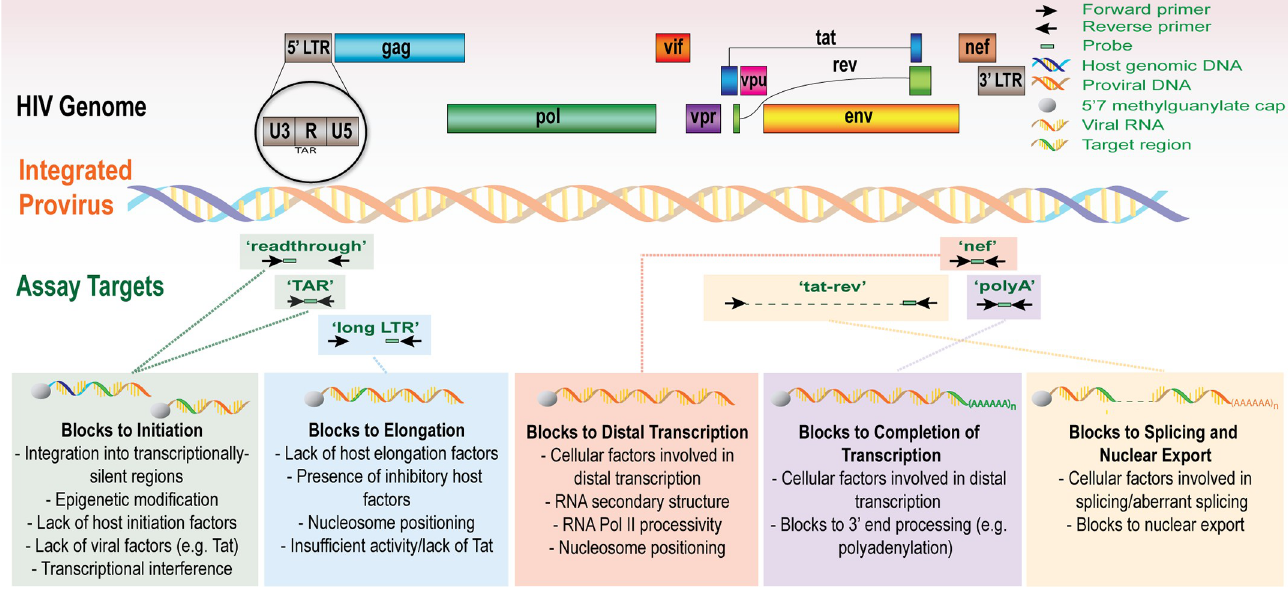
Fig 1. The HIV genome and the targets for transcription profiling assays. This schematic shows the genetic organization of proviral HIV DNA and the HIV ‘transcription profiling’ assays targeting specific RNA sequence regions that provide insight into blocks to transcription. Some proposed mechanisms underlying the blocks to transcription initiation, elongation, and splicing are